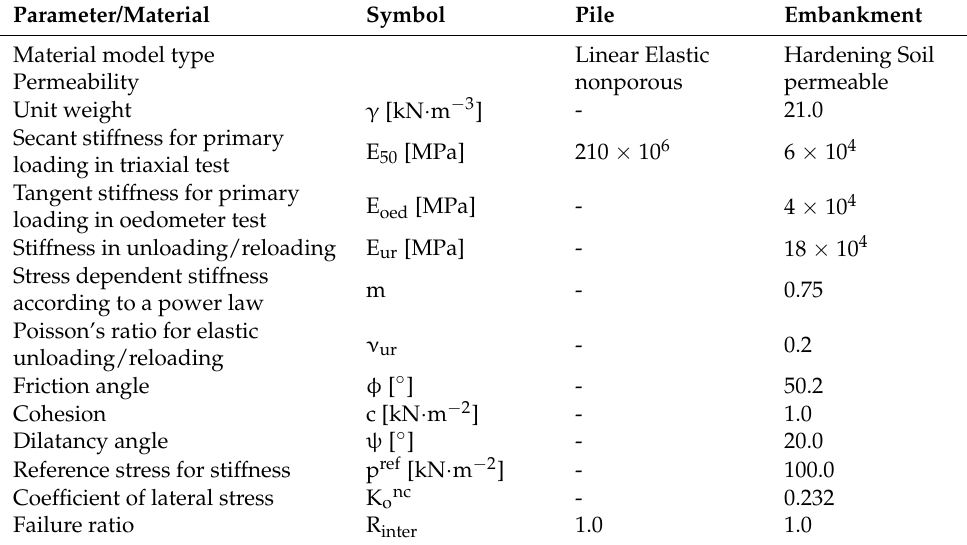
Table 1. Material characteristics of the used numerical model of piled embankment [27].